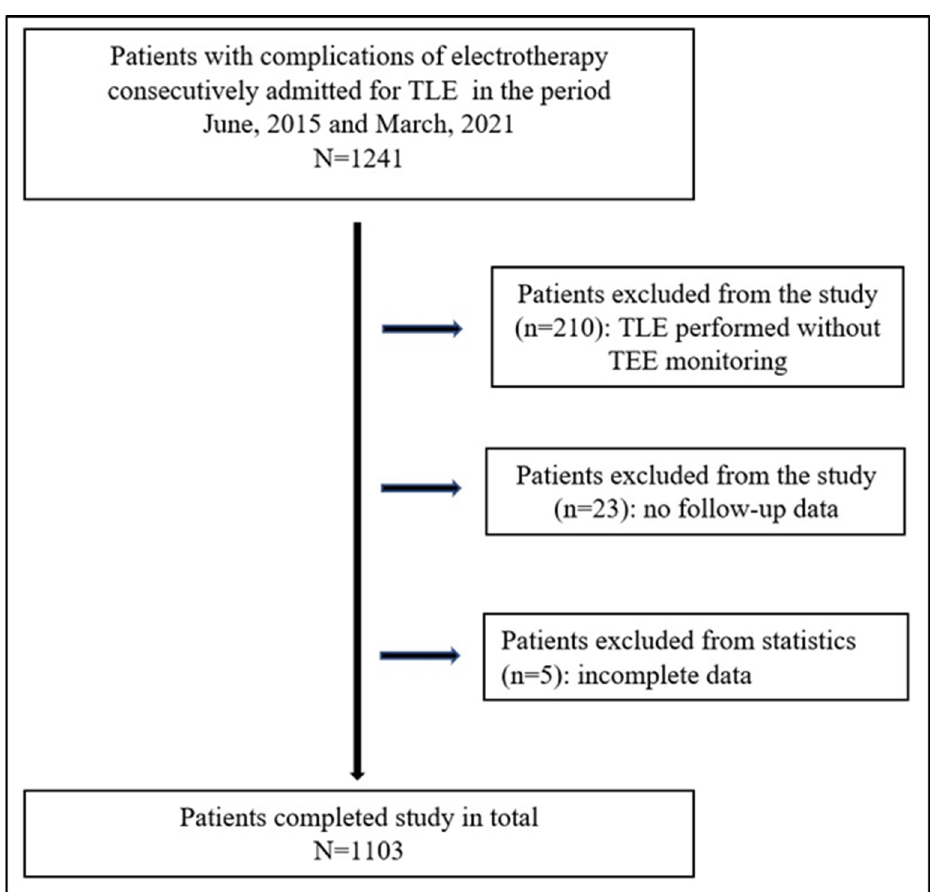
Figure 1. Flow chart of the recruitment process towards the study group.